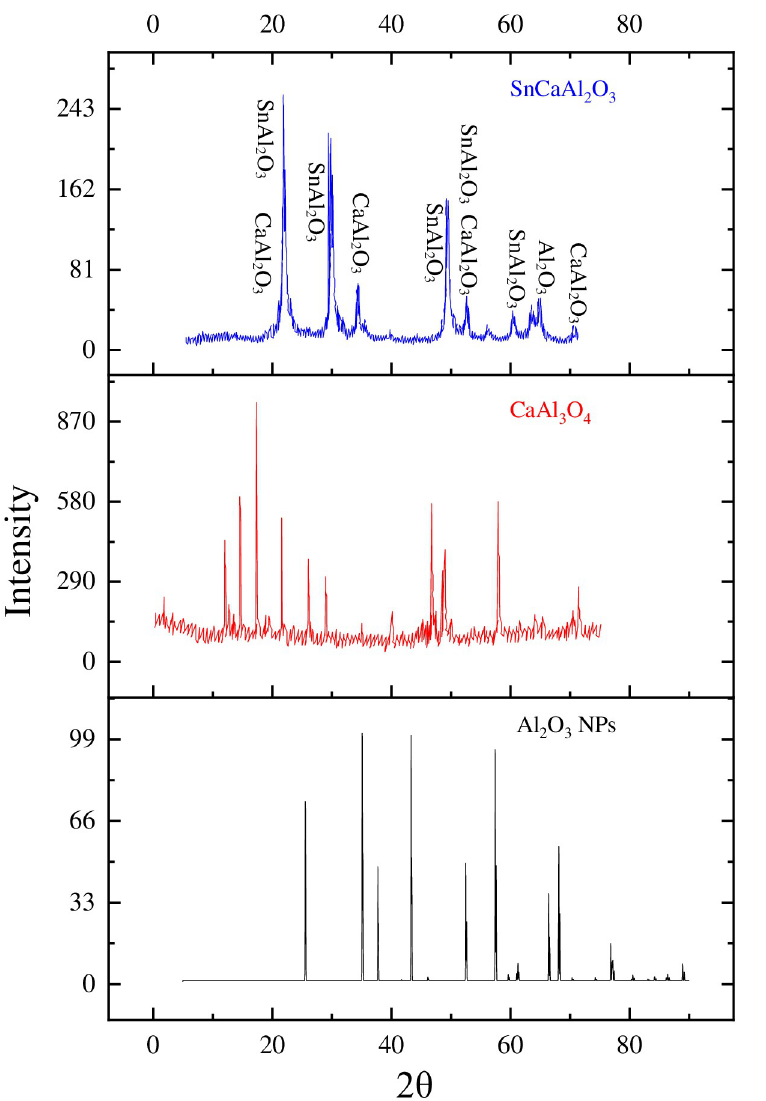
Fig 3. XRD diffraction patterns of Al 2 O 3 and SnCaAl 2 O 3 nanoparticles.